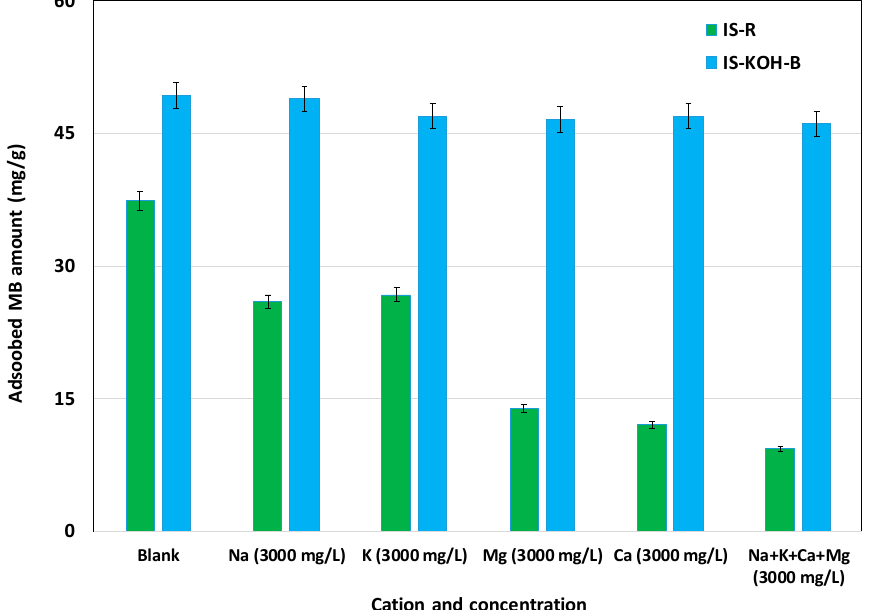
Figure 6. Effect of competition with other cations on MB removal (C0 = 50 mg L − 1 ; pH = 6.8 = 1 g L − 1 ; t = 3 h).